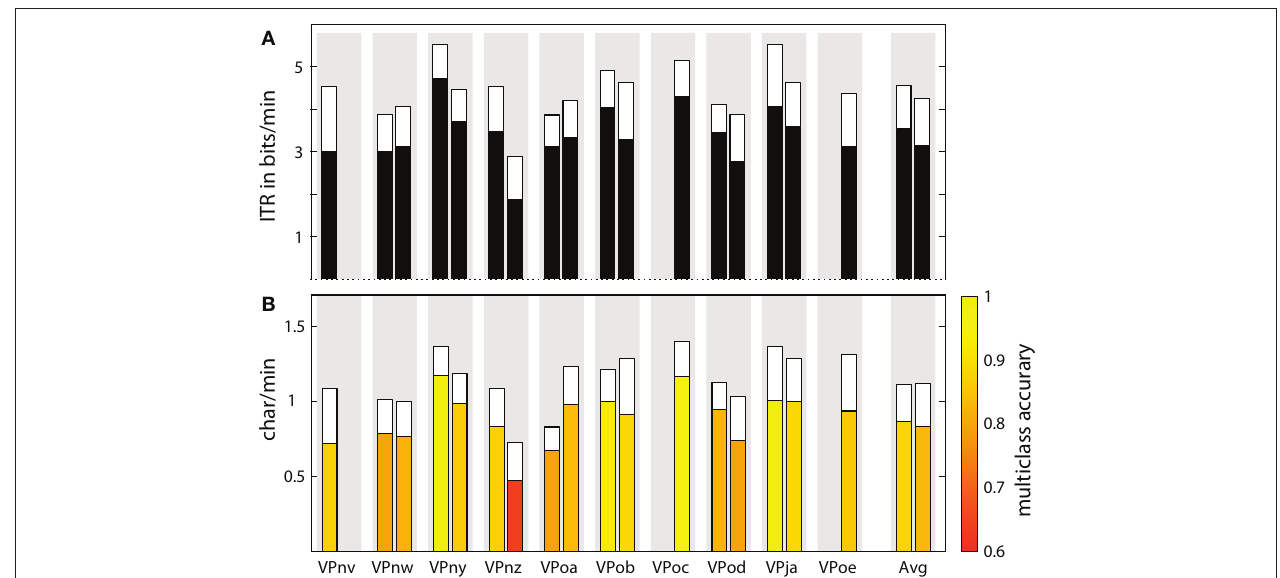
FIguRE 7 | For each subject and both sentences the bar plots show the multiclass accuracy and the resulting Information Transfer Rate (A) and the spelling speed in characters per minute (B). The white extensions of the bars mark the potential increase, that could result if individual pauses are disregarded